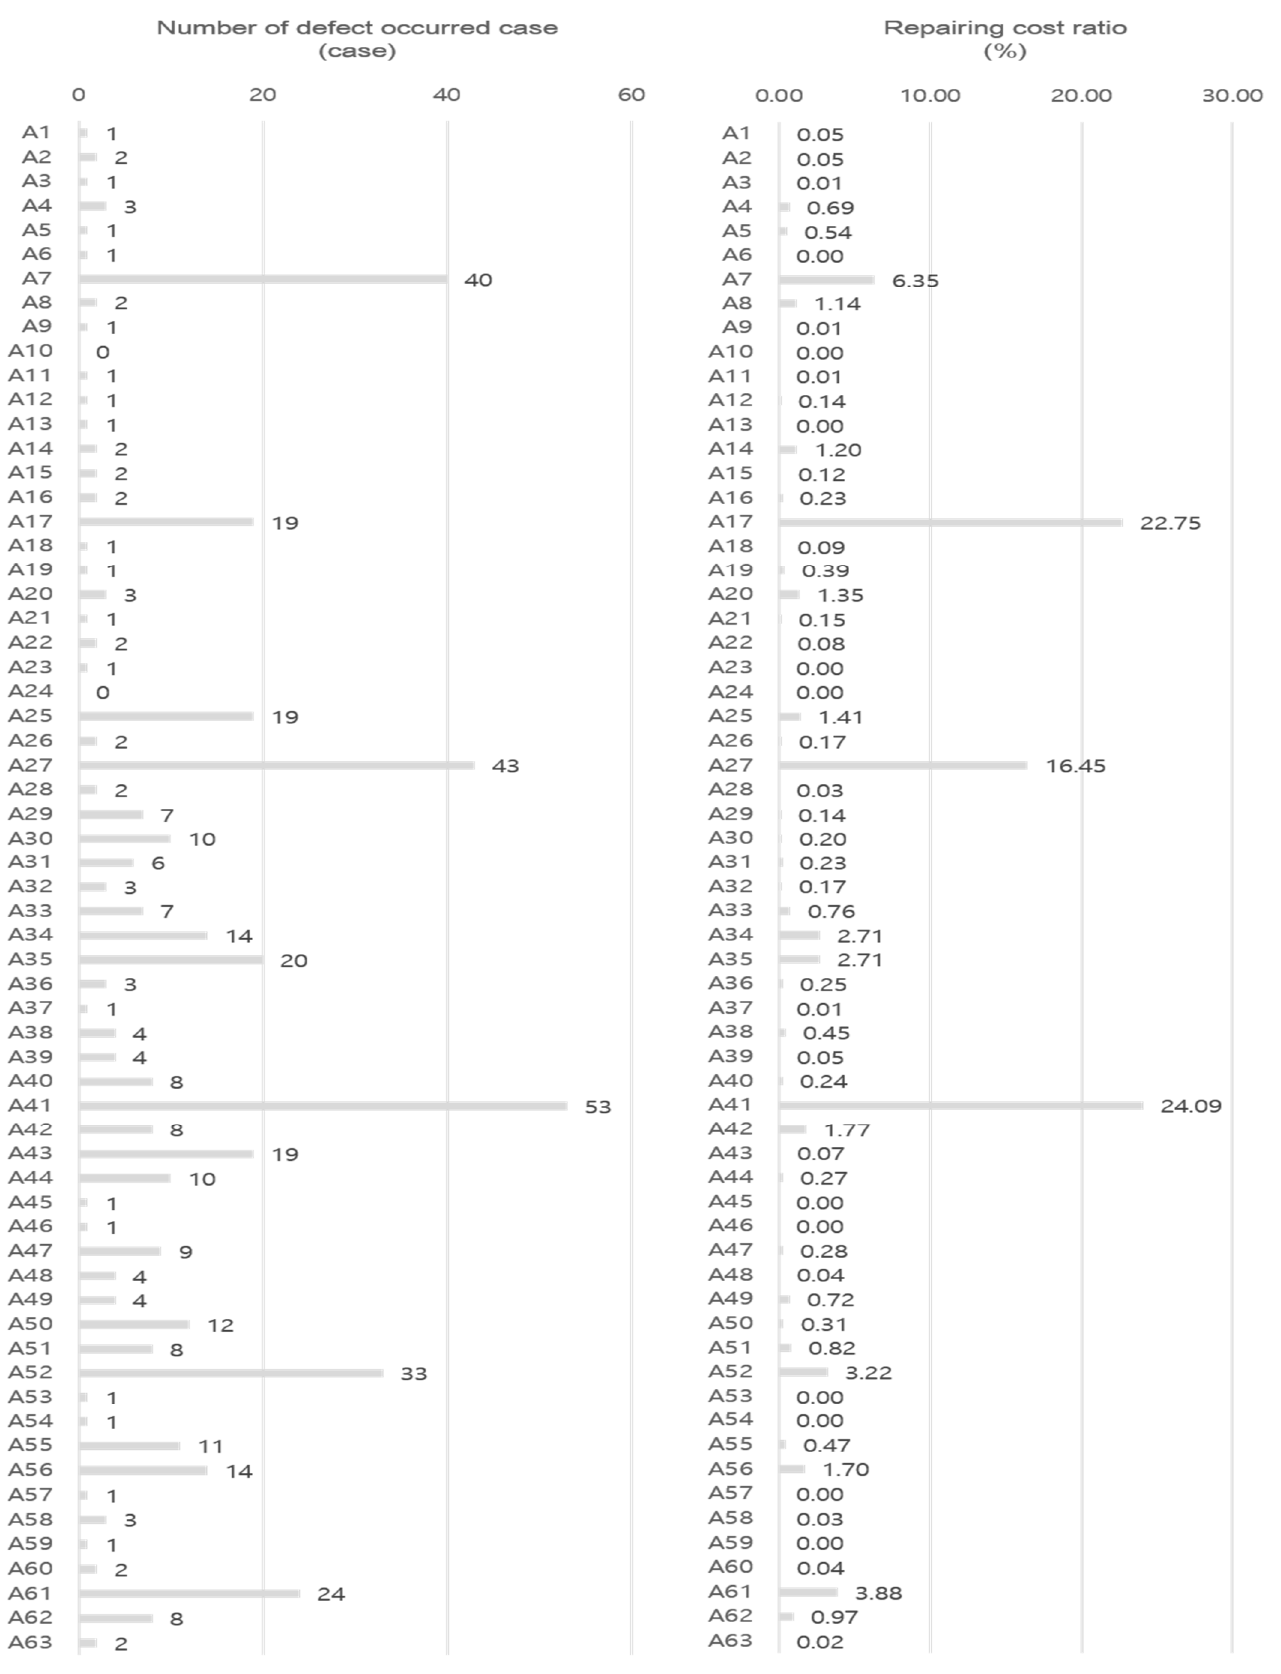
Figure 2. Defect occurrence and repair cost ratio on total defect index.